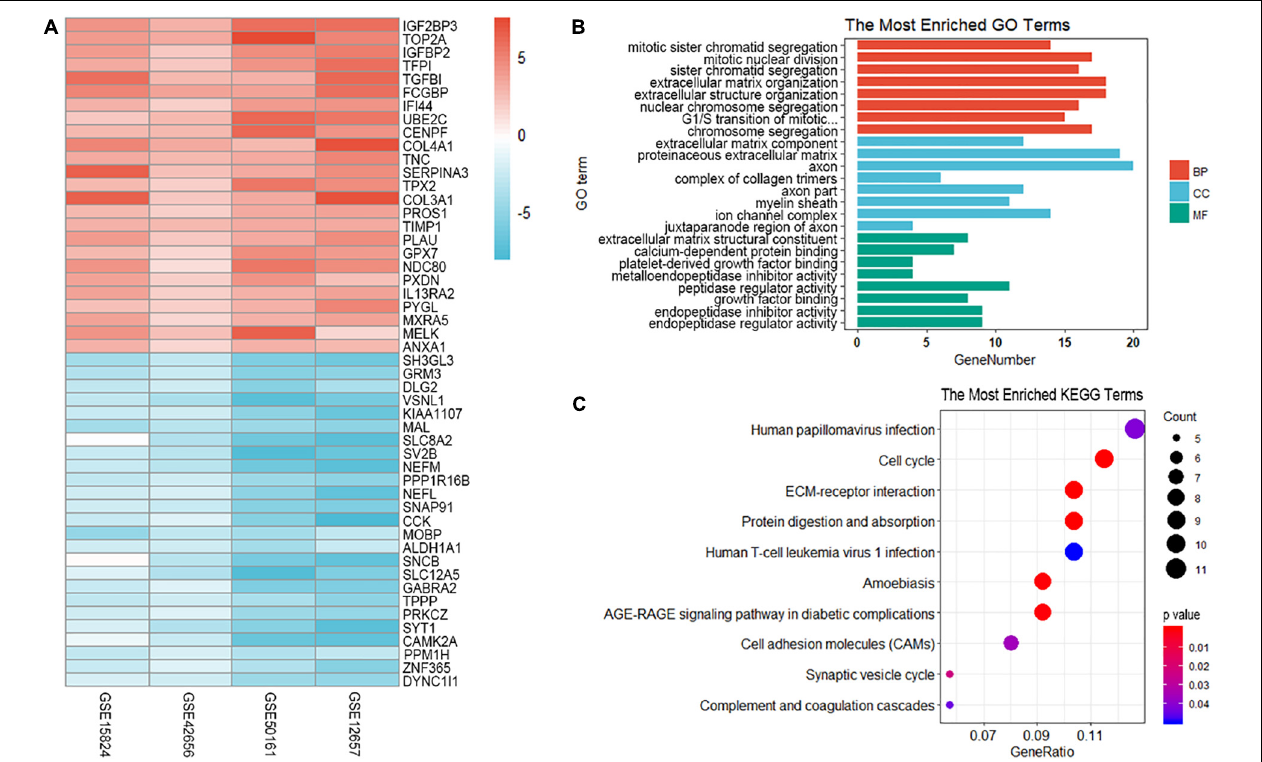
FIGURE 2 | Visualization and enrichment analysis of differentially expressed genes. (A) The heatmap of the top 50 DEGs. (B) GO enrichment analysis of differentially expressed genes. BP, biological process; CC, cellular component; MF, molecular function; (C) KEGG enrichment analysis of differentially expressed genes. The size of the dot represents the count number of genes in one KEGG